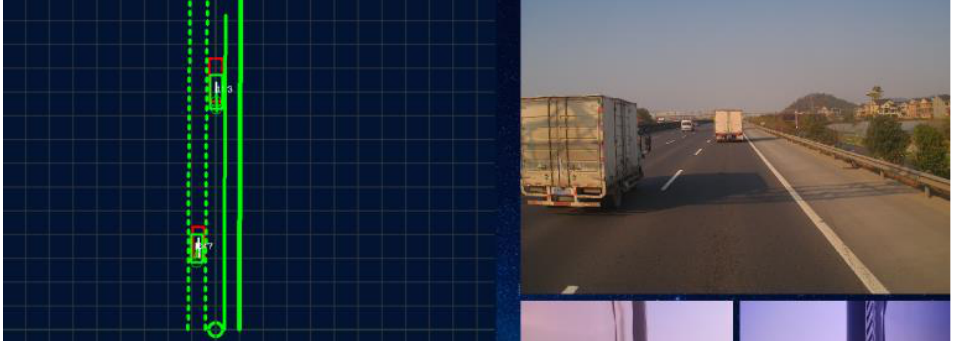
Figure 12. Mono camera-based tracking system.